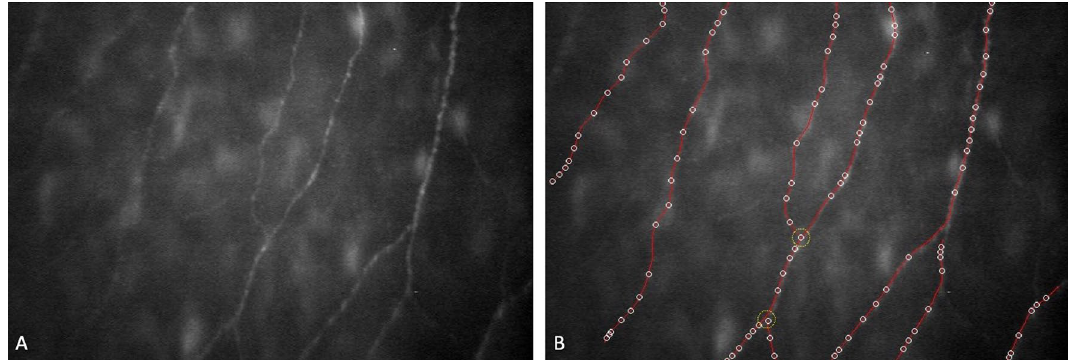
Figure 1. The source image of the SBNP fibers ( A ) and the segmentation sample ( B ). The software traces nerve fibers and detects the beadings and automatically provides CCM values.